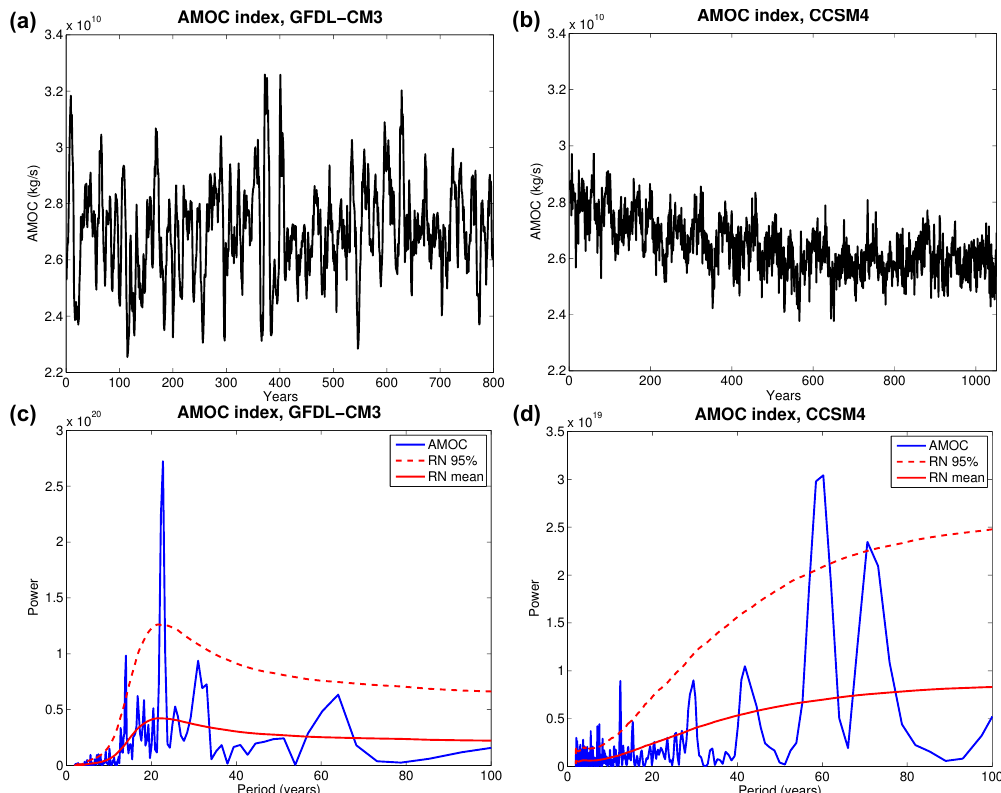
Figure 3. Characterization of the Atlantic meridional overturning circulation (AMOC) index variables used in this paper. Panels (a) and (b) show the AMOC index time series (defined in the text) for the preindustrial control simulations of GFDL-CM3 and CCSM4, respectively. Panels (c) and (d) show their respective power spectra with a best-fit red noise (RN) spectrum (computed as in Schneider and Neumaier, 2001) and an estimated 95% confidence